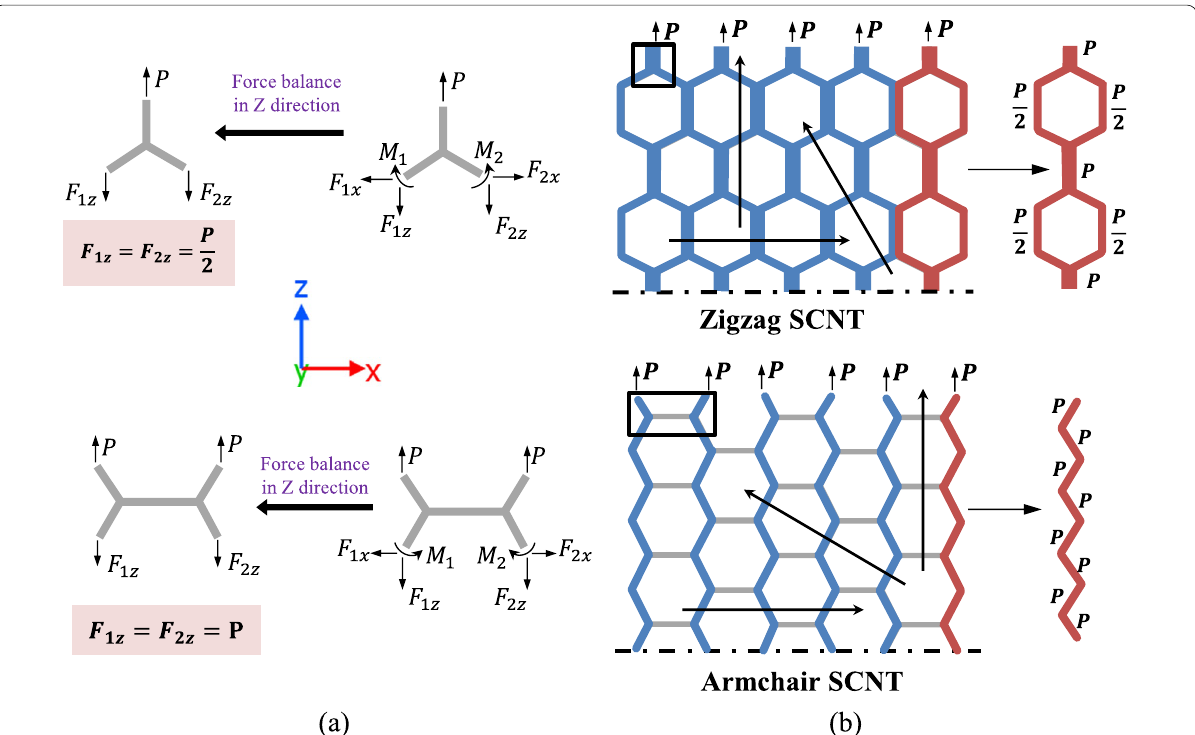
Fig. 10 Demonstration of the force transmission modes of different SCNT structures. a Force balance analysis of free-body diagrams of zigzag and armchair SCNTs; b Force transmission modes of the zigzag and armchair